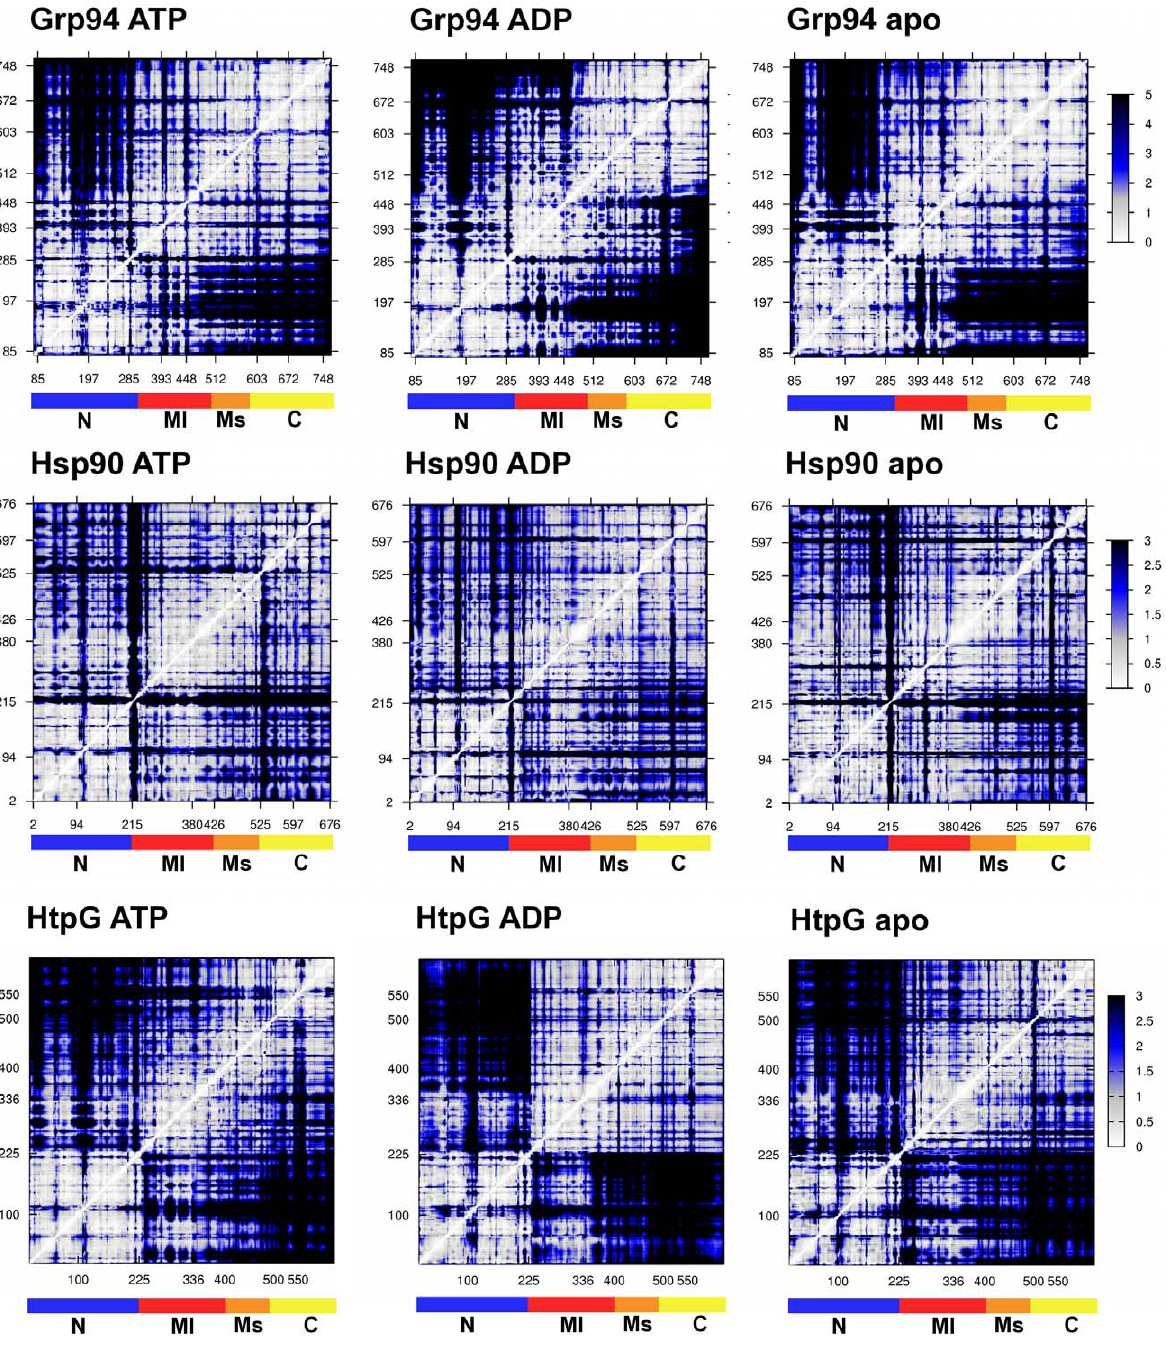
Figure 4. Distance fluctuation matrices for Grp94, Hsp90 and HtpG protomers in all different ligand states. The magnitude of pairwise distance fluctuations is color coded from white (small fluctuations) to black (large fluctuations). The different absolute scale of pairwise fluctuations between Grp94, Hsp90 and HtpG reflects the different internal mobility of the three molecules.